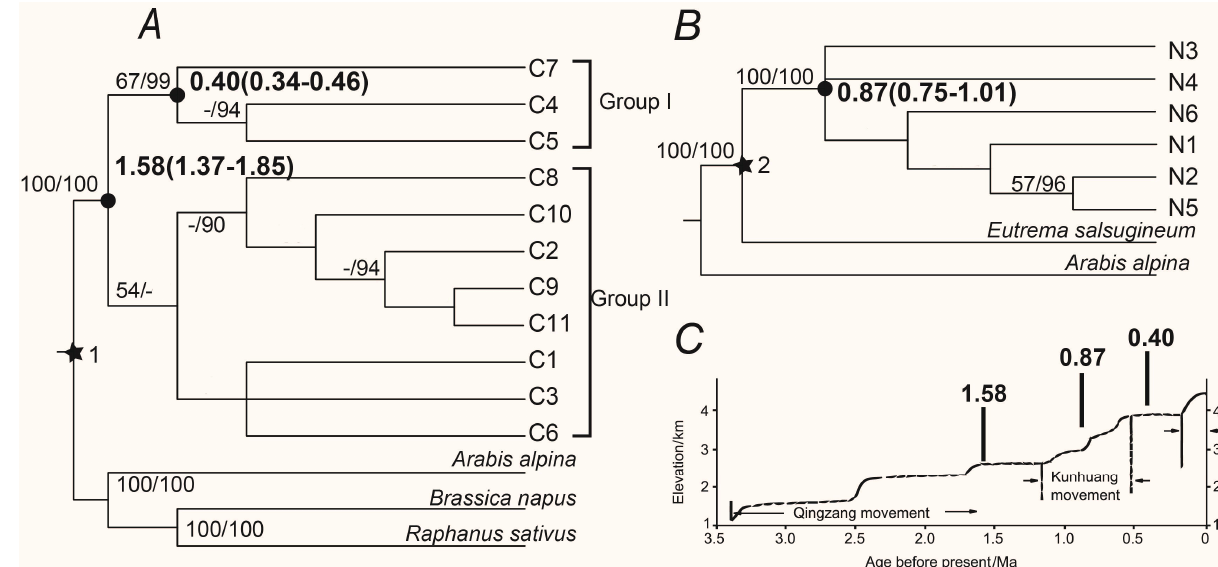
Figure 2. Phylogenetic trees produced by Bayesian inference of cpDNA and ZIP of Thlaspi arvense are presented in ( A ) and ( B ) Numbers above the branches indicate the bootstrap values for ML/BI analyses. Dash lines represent bootstrap values that lower than 50 or posterior probabilities that lower than 90. The divergence times between T. arvense and outgroups referenced the work of Beilstein et al. [30] and were marked as stars. Star 1 indicates 38.4 Ma (33.2–45.0 Ma) and star 2 indicates 35.9 Ma (31.1–41.7 Ma). Inferred dates in Ma before present are given beside the nodes denoted with black dots.